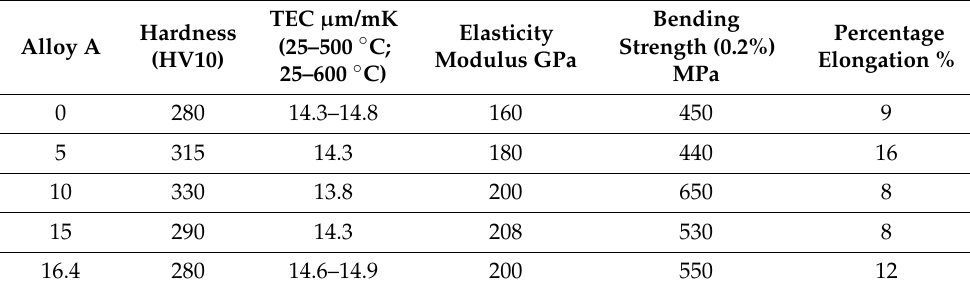
Table 2. Properties of the analyzed alloys as cast condition (hardness, thermal expansion coefficient, elasticity modulus, bending strength, elongation resistance) (0-A [22], 5-A [23], 10-A [24], 15-A [25] and 16.4-A [26]).